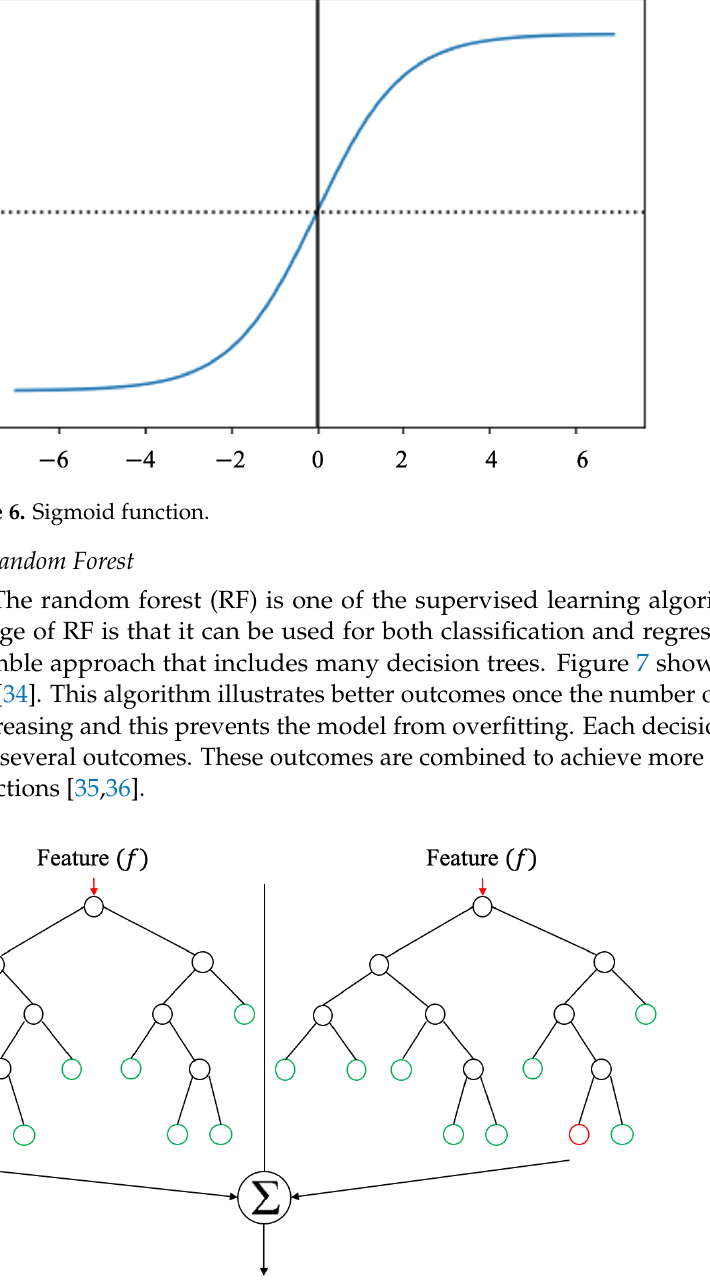
Figure 7. Random forest with two